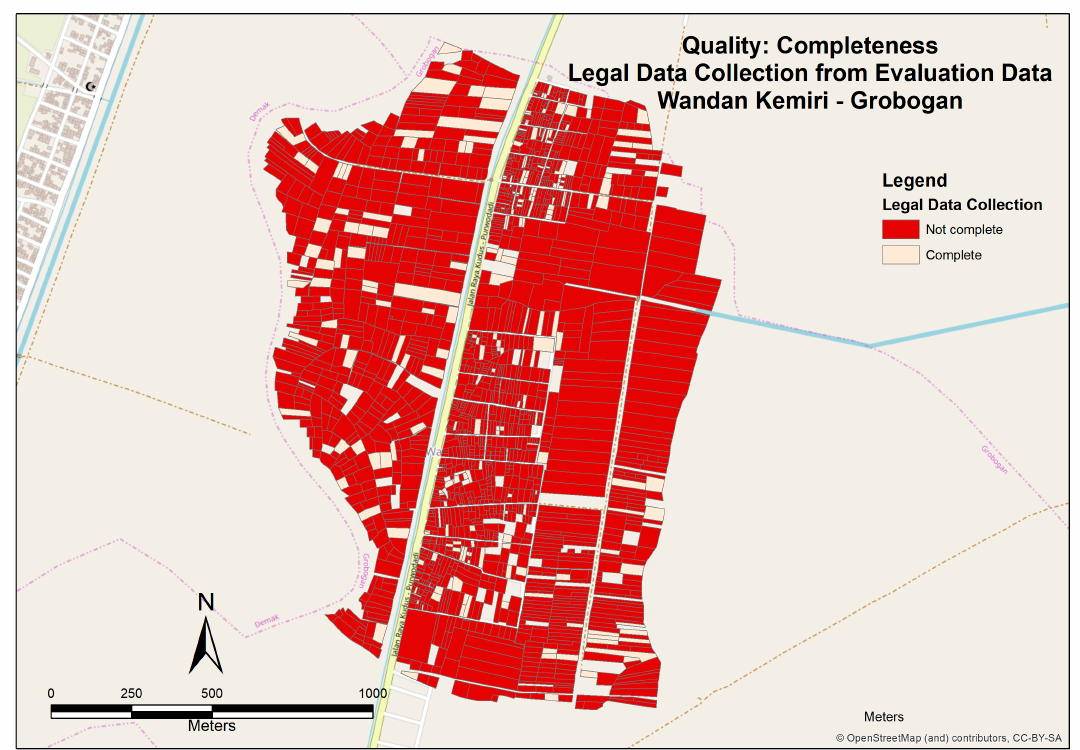
Figure A6. Completeness of the legal data collection (those that were checked by the land office and ready for first land titling) from the evaluation data in Grobogan.